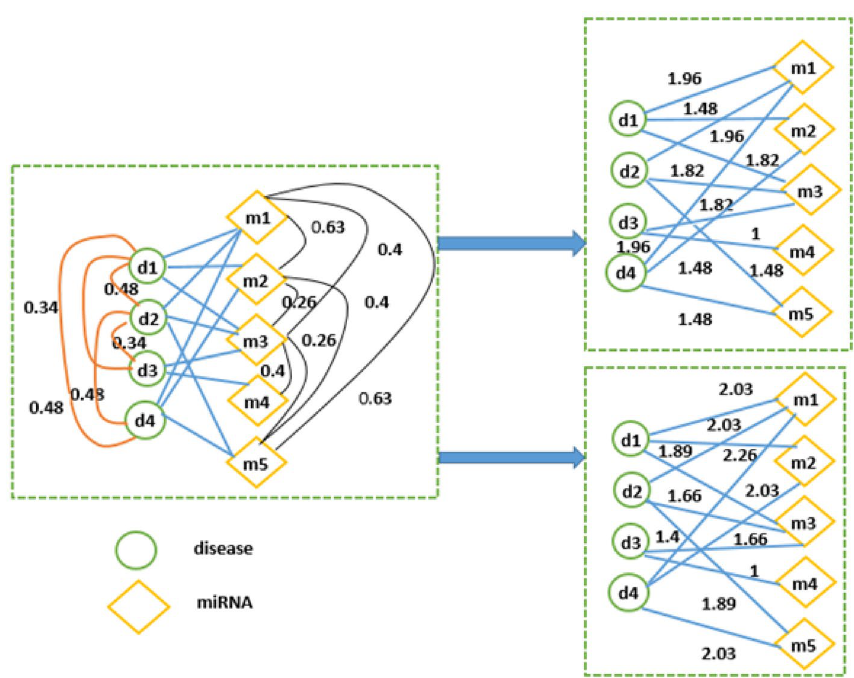
Figure 4. Illustrations of the process of weight assignment in disease space and miRNA